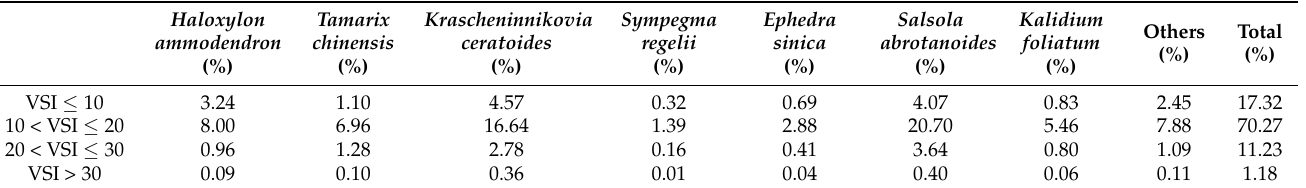
Figure 2. Vegetation Sensitivity Index (VSI, ( A )) and its contributions ( B ) from the temperature and precipitation during the plant growing season (GST and GSP, respectively, in red and blue) and temperature vegetation dryness index (TVDI, in green). Table 2. Vegetation Sensitivity Index (VSI) among different desert scrub communities across the Qaidam Basin.